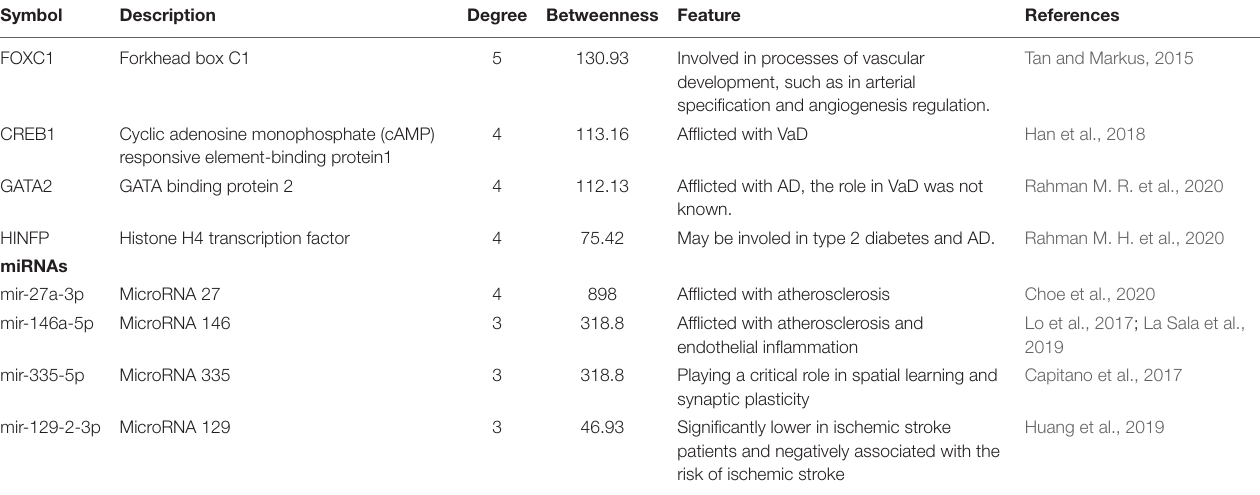
TABLE 5 | Transcription factors (TFs) and miRNAs identified as transcriptional and/or posttranscriptional regulators of the hub genes in the protein–protein interaction network of